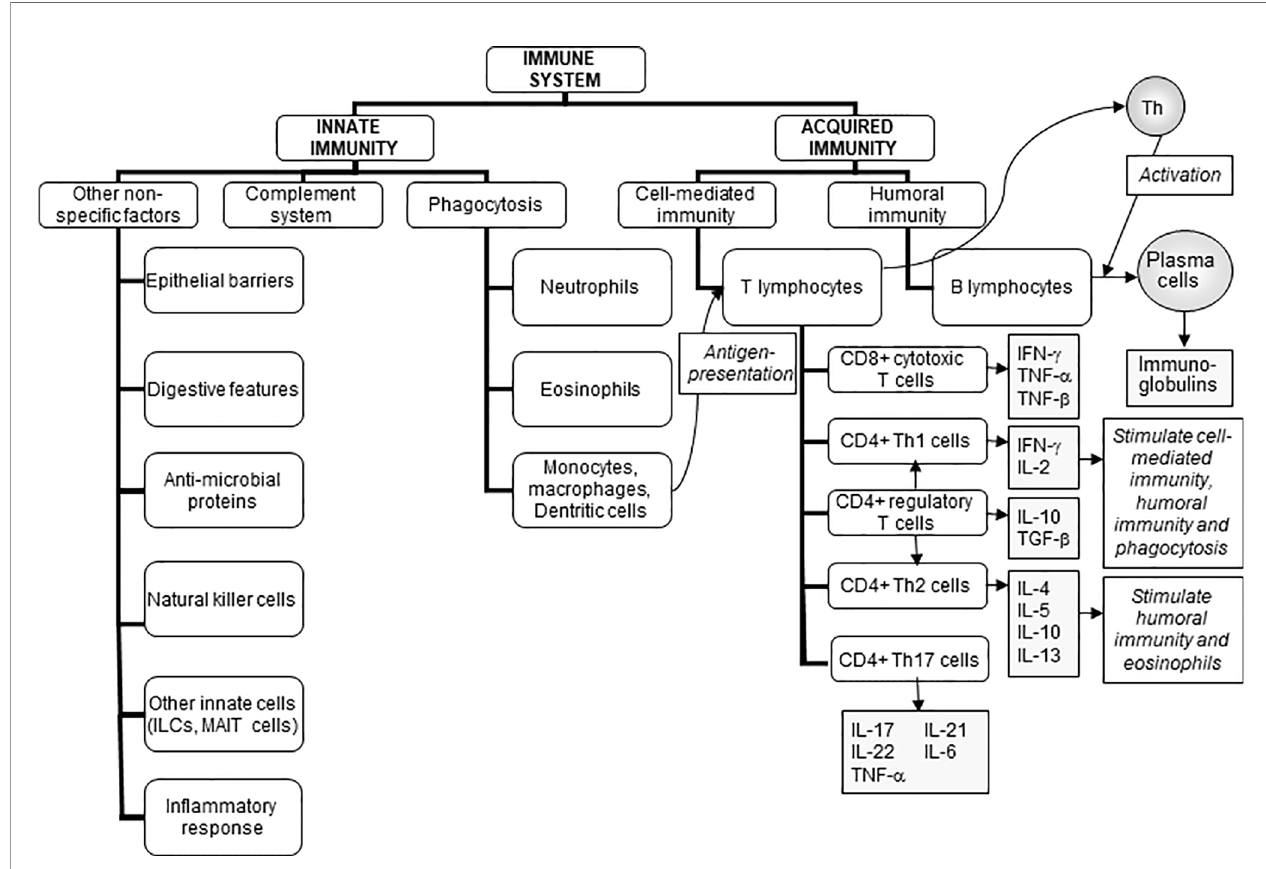
FIGURE 1 | The components of the immune system and their division into innate and acquired immunity. IFN, interferon; IL, interleukin; ILCs, innate lymphoid cells; MAIT, mucosal associated invariant T; TGF, transforming growth factor; TNF, tumour necrosis factor. Taken from